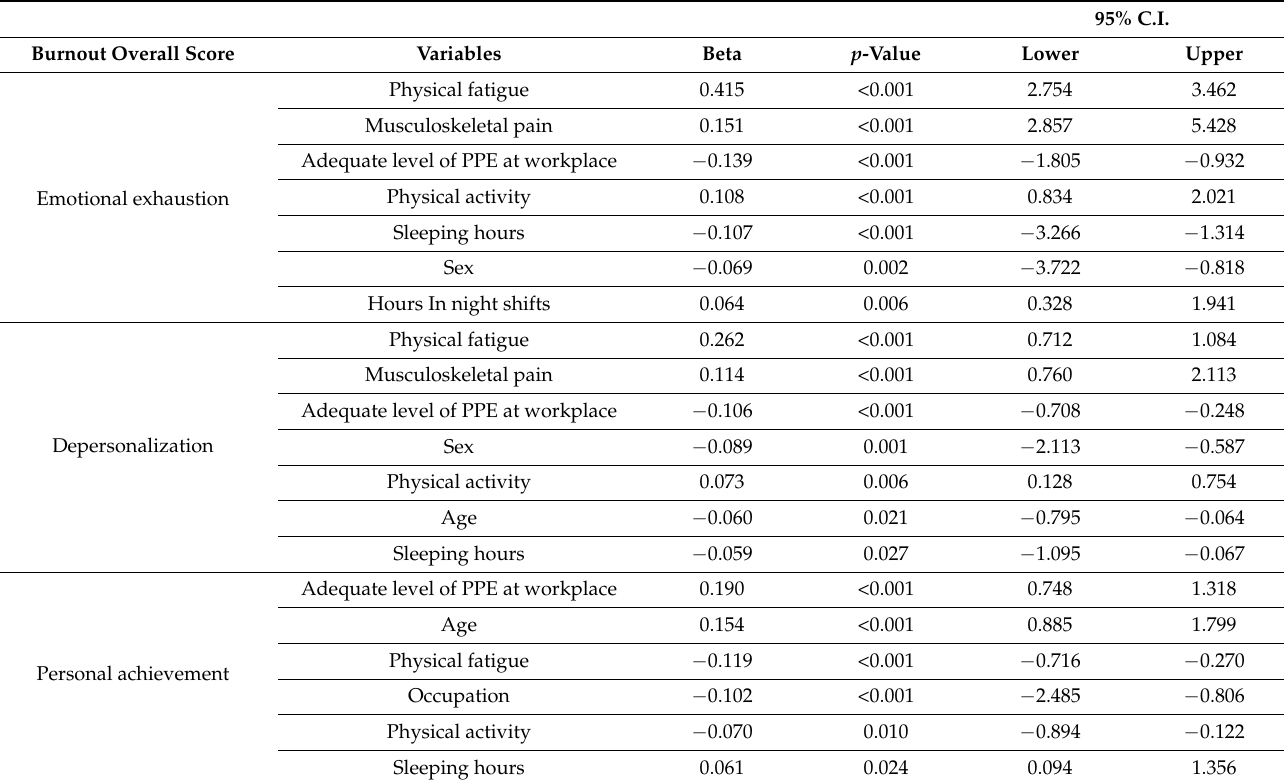
Table 5. Regression models for the overall scores of burnout components.